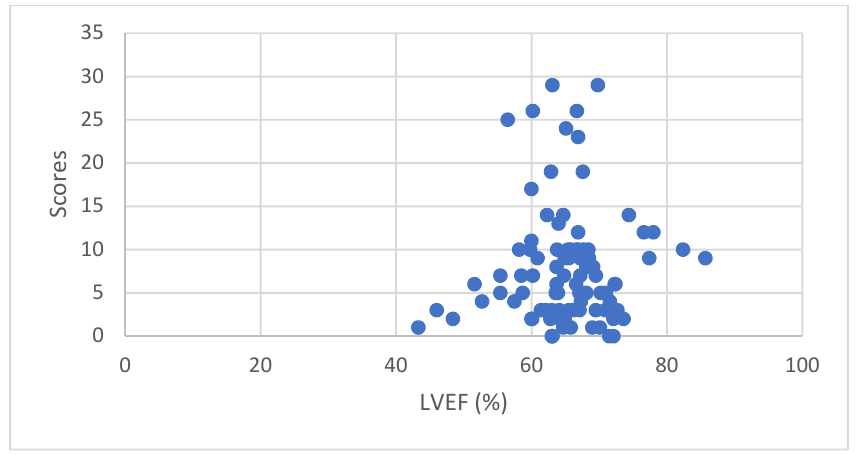
Figure 4. LVEF and Heart Risk View-S scores for 201 Tl uptake reduction.